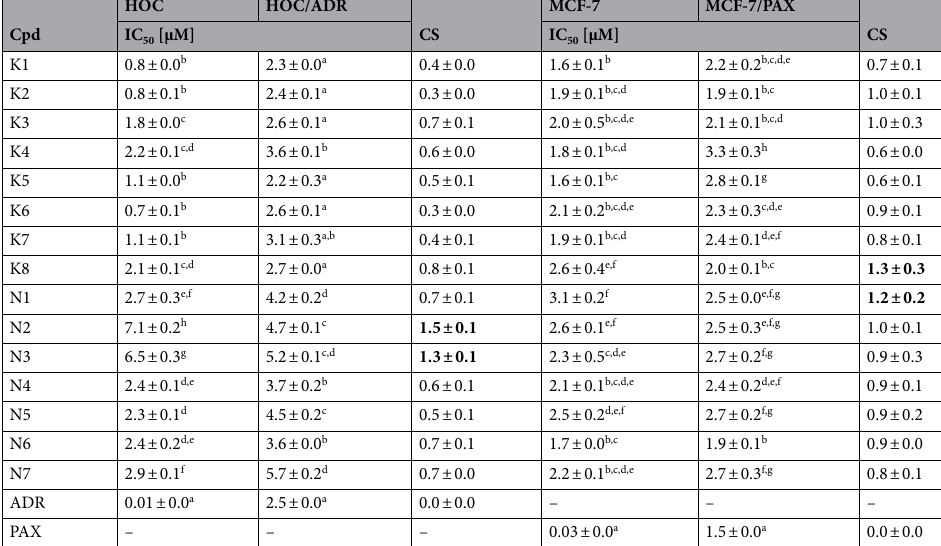
Table 1. Cytotoxic potential of selenocompounds against sensitive ovarian (HOC) and breast carcinoma (MCF-7) cell lines and their Adriamycin (ADR) and paclitaxel (PAX) resistant sub-lines with the corresponding collateral sensitivity (CS) index. Data are expressed as the average inhibitory concentration (IC 50 ) and collateral sensitivity index (CS) of three repetitions with standard error of the mean (SEM). The selectivity is considered as a strongly selective, if CS value is higher than 6, moderately selective if 6 > CS > 3, slightly selective if 3 > CS > 1 and non-selective if CS is less than 1. The statistical differences between compounds were calculated by one-way analysis of variance (ANOVA) and Duncan’s post hoc test (p ˂ 0.05) within one cell line, where different letters (a-h) denoted the significances; the different cell lines were evaluated independently on each other. Significant values are in [bold].